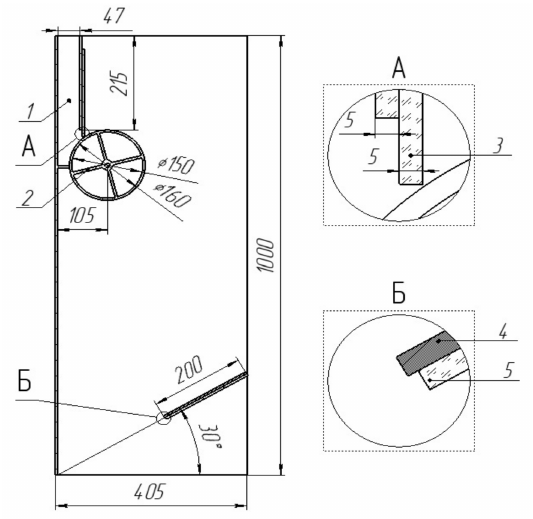
Figure 8. Discharge-drop test: (1) Container; (2) drum; (3) plug; (4) collision plate; (5) collision plate